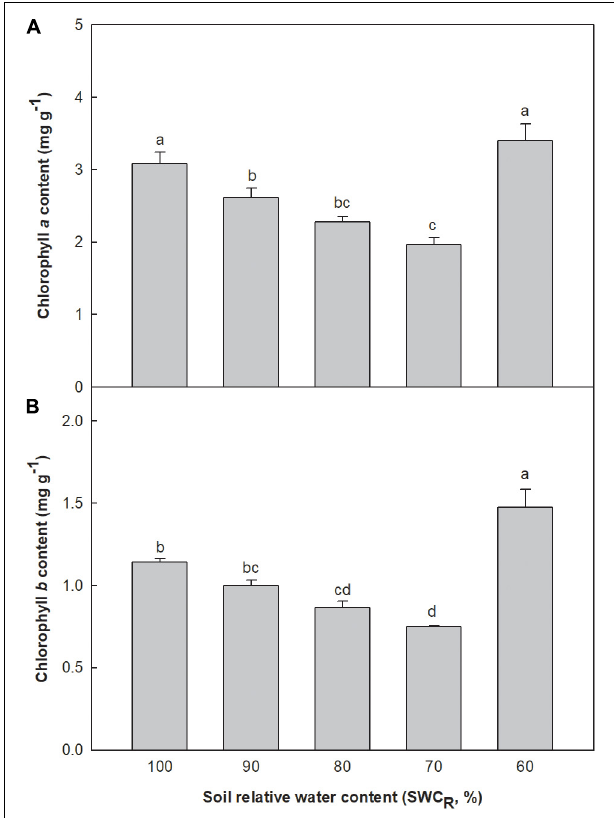
FIGURE 1 | Effect of different water supplies on chlorophyll a and b contents (mg g – 1 ) [ (A) chlorophyll a ; (B) chlorophyll b . The means ( n = 5) followed by different letters in the same parameter are significantly different ( p ≤ 0.05), according to one-way